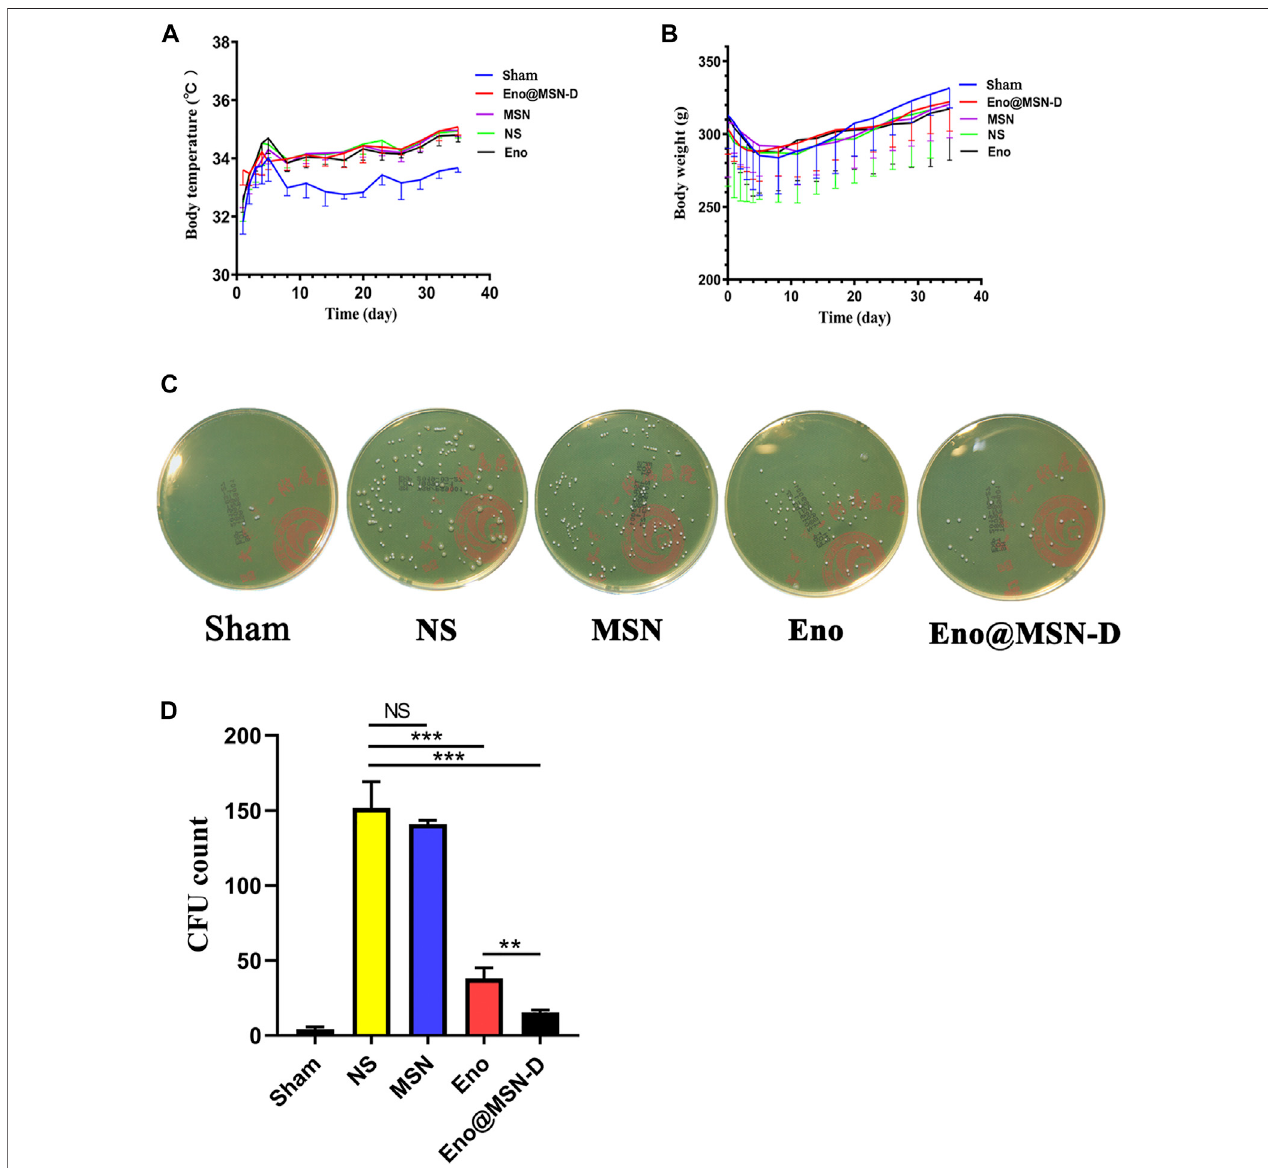
FIGURE7|(A) Curveofbodytemperaturechangeinrats. (B) Curveofbodyweightchangeinrats. (C) Platecolonycountafterultrasonicconcussionofbacteriaon the surface of a titanium rod. (D) Statistical chart of plate colony count after the ultrasound treatment.